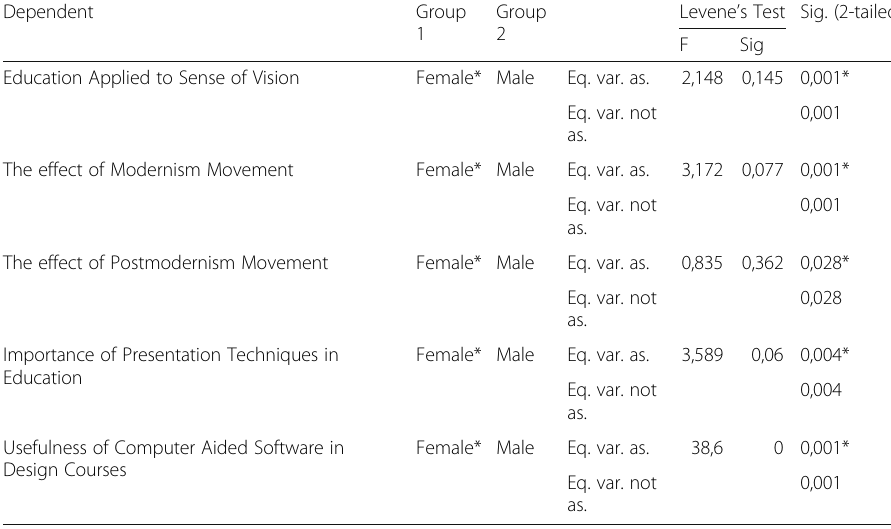
Table 7 Independent Sample t-test